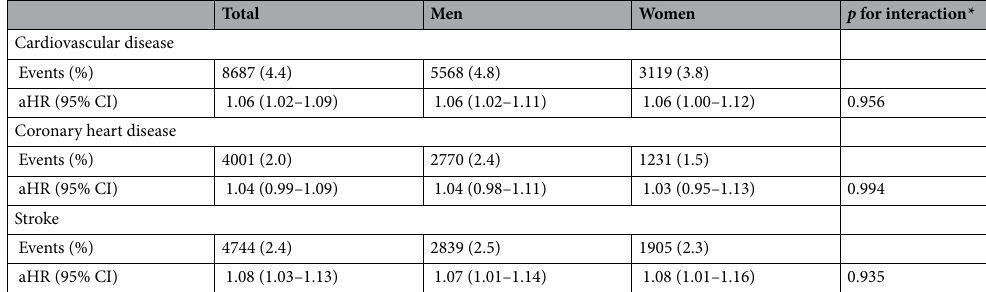
Table 2. Association of hemoglobin variability on cardiovascular disease (coronary heart disease and stroke). Hazard ratio calculated by Cox proportional hazards regression analysis after adjustments for age, sex, initial hemoglobin level, change in hemoglobin level, household income, smoking, alcohol consumption, physical activity, systolic blood pressure, fasting serum glucose, total cholesterol, and Charlson comorbidity index. aHR adjusted hazard ratio, CI confidence interval. *p value for interaction between men and women.